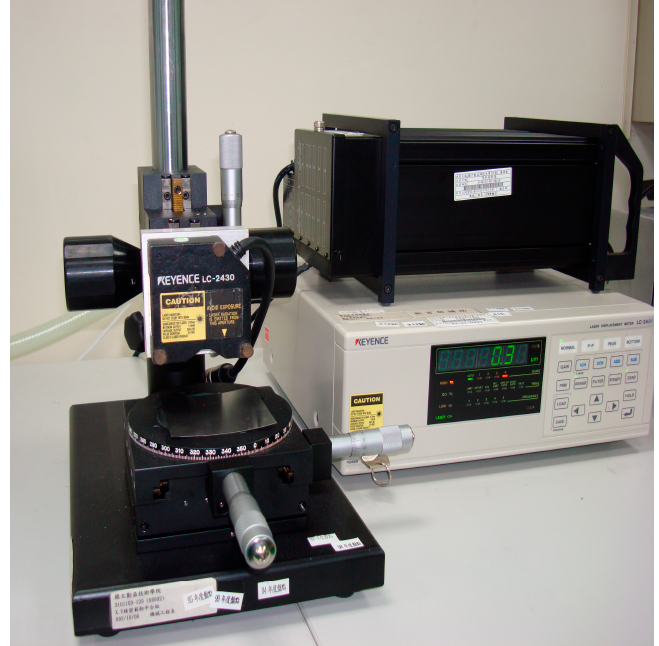
Figure 9. Laser displacement system (Keyence LC-2430) for contour measurements of stamped stainless steel plates.